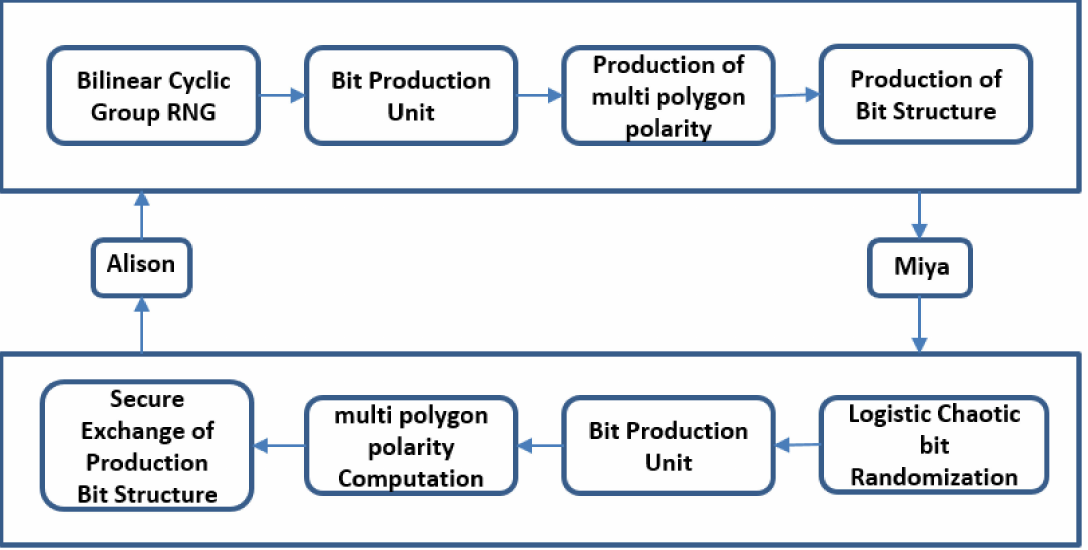
Figure 8. Proposed polygon random polarization-based